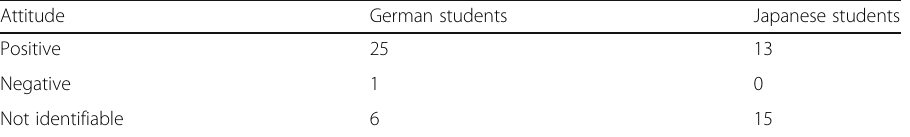
Table 7 Comparison of the attitudes towards creativity in chemistry classes identified in the concept maps of German students ( N = 32) and Japanese students ( N = 28) Attitude German students Japanese